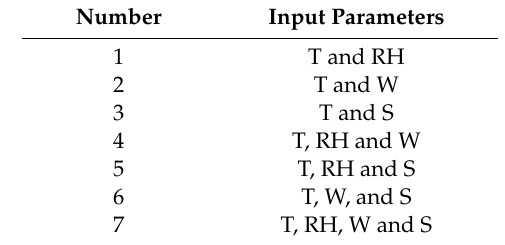
Table 3. Parameters involved in defined scenarios of GPR, IBK, RF and SVR models.